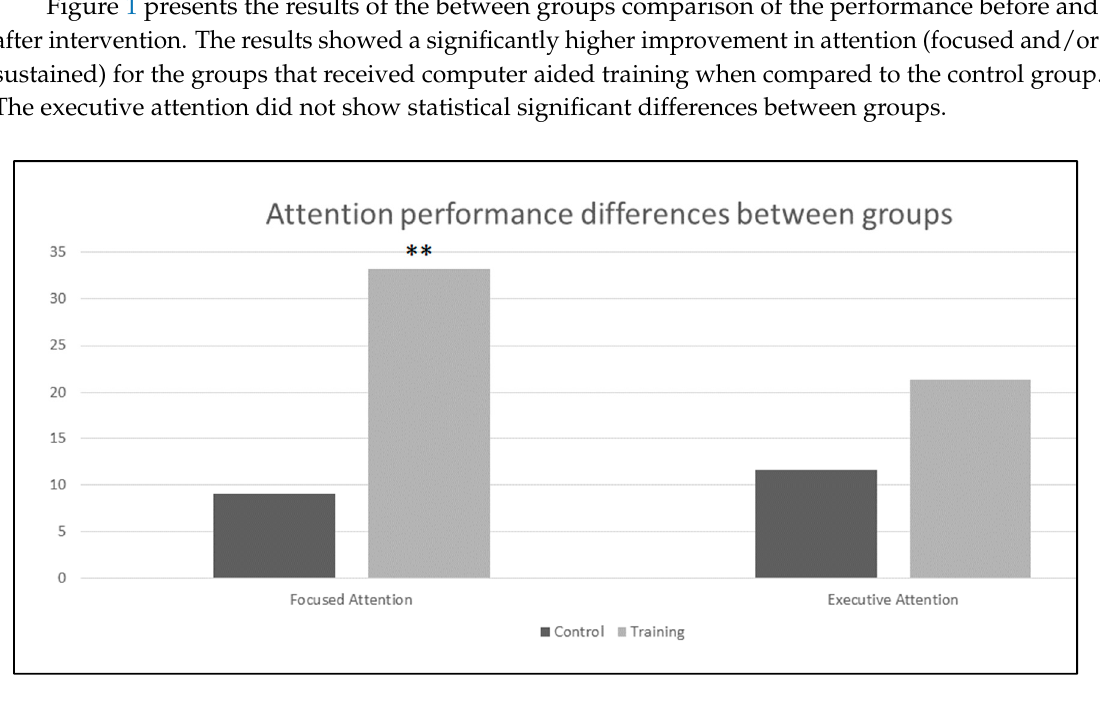
Figure 1. The difference scores at the attention performance. Note: * indicates the statistical significance between within groups comparison for p < 0.05.